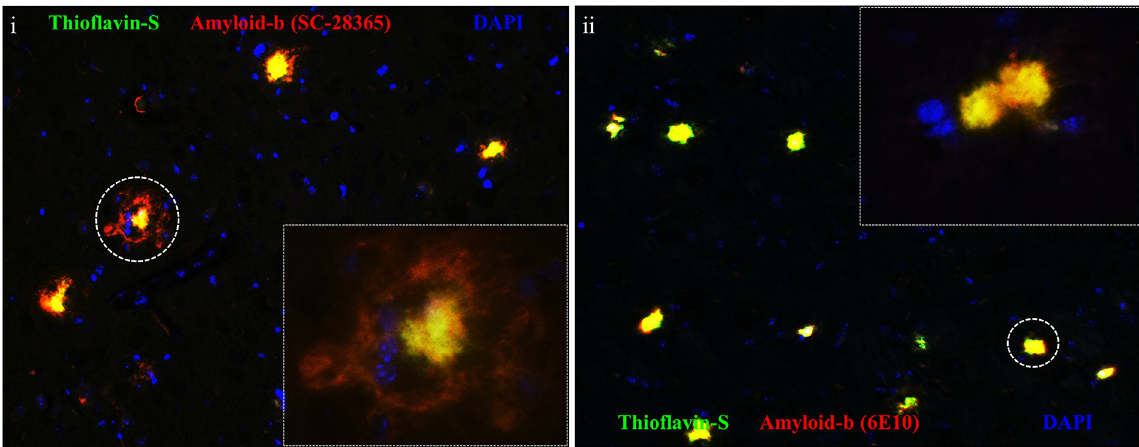
Fig 2. Thioflavin-S positive plaque quantification. Tissue sections were incubated with an an antibody against amyloid- β , SC-28365 (i) or 6E10 (ii) (-red- excitation λ : 555 emission λ :580). The sections were then co-stained with Thioflavin-S (-green- excitation λ : 430 emission λ :550). Areas of co-localisation were considered as fibrillar (insoluble) amyloid